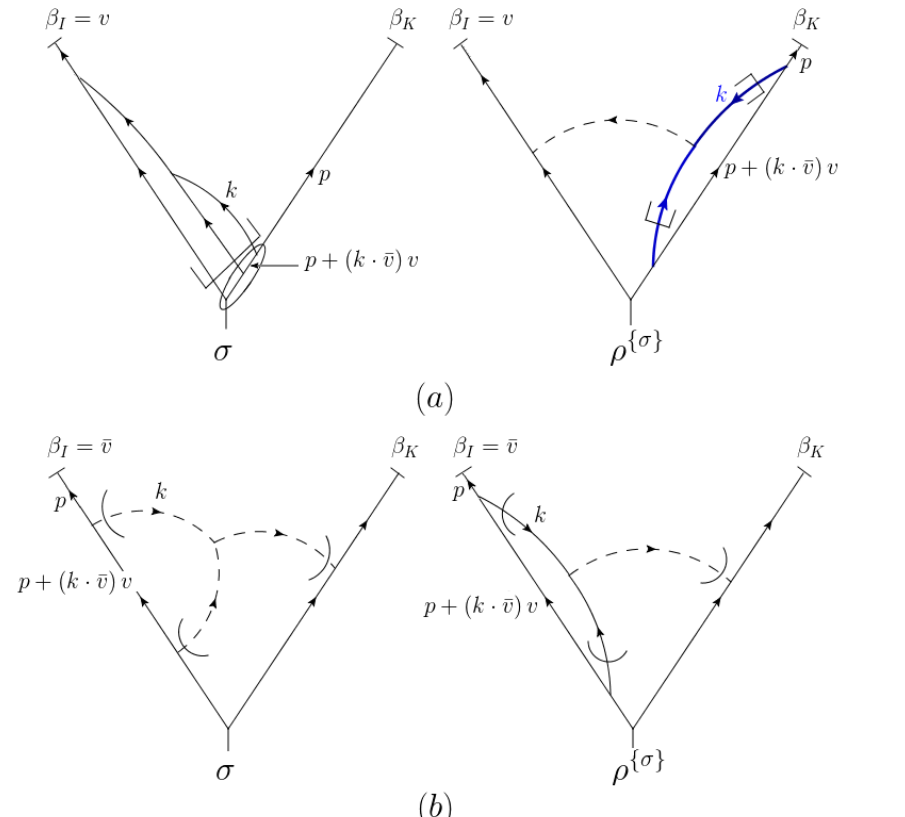
Figure 6. Examples of case (Cii), where both k (cid:22) and p (cid:22) are lightlike in (cid:26) f (cid:27) g , and specially, k (cid:22) is in the direction of v (cid:22) . For each of these diagrams, the jet subgraph J I ( J K ) consists of the solid lines connected to the external line marked (cid:12) I ( (cid:12) K ) in the (cid:12)gure, outside of the lines that are encircled. The encircled propagators are in the hard subgraph, and the dashed lines are soft. The propagators marked bold and blue are for later use in section 2.4. The upper row ( a ) describes the case where t (cid:27) acts as a hard-collinear approximation on k (cid:22) with v (cid:22) = (cid:12) (cid:22) row ( b ) describes a soft-collinear approximation with v (cid:22) = (cid:12) component of k (cid:22) which joins p (cid:22) is ( k (cid:1) v ) v (cid:22) , so that k (cid:22) is pinched as in eq. (2.16) in the direction of v (cid:22) from our analysis. Meanwhile, the propagator with momentum p (cid:22) + ( k (cid:1) v ) v (cid:22) is put on shell as a jet